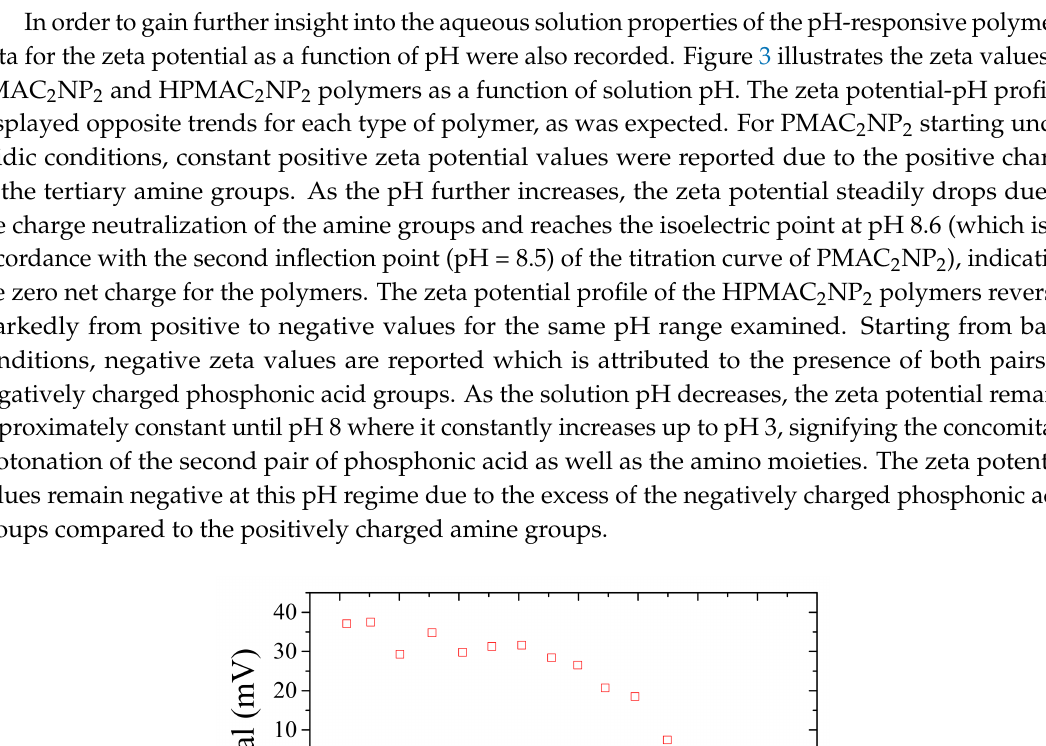
) polymers at c = 0.1 wt %. (cid:35)